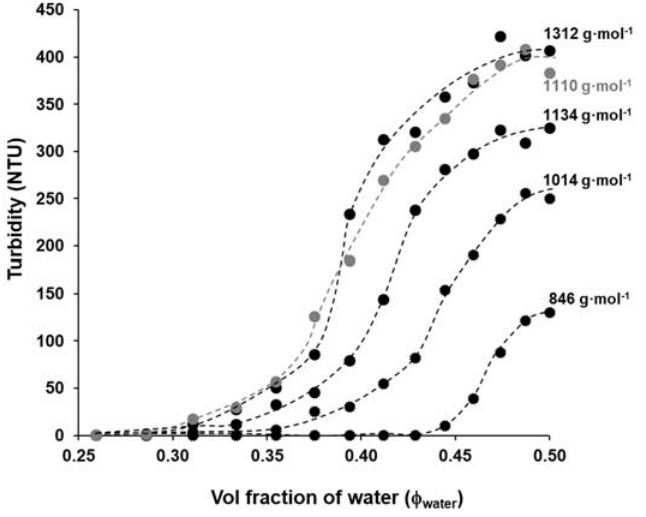
Figure 6. Turbidimetric titration of DMSO-based PES solution (80 min polycondensation time) with water; log volume fraction of water (Log Φ water ) needed to incipient precipitation as a function of the log of the corresponding volume fraction of polyester (Log Φ PES ).